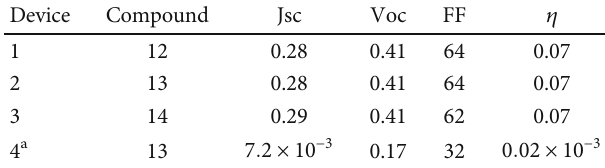
Table 4: Electrical parameters and e ffi ciency of solar cells sensitized with compounds 12-14, where Jsc is the short circuit current density (mA · cm 2 ), Voc is the open circuit voltage (V), FF is the fi ll factor (%), and η is the conversion e ffi ciency (%). The measurements